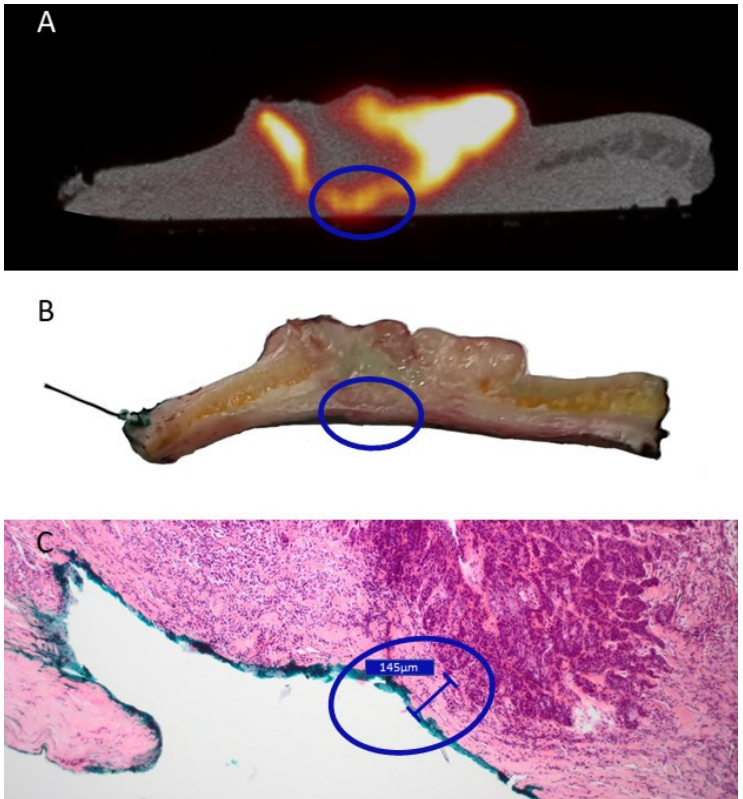
Figure 4. Correlation between the close margin as described during pathological assessment and PET/CT-imaging of a cutaneous squamous cell carcinoma of the scalp in patient 3. The blue circle